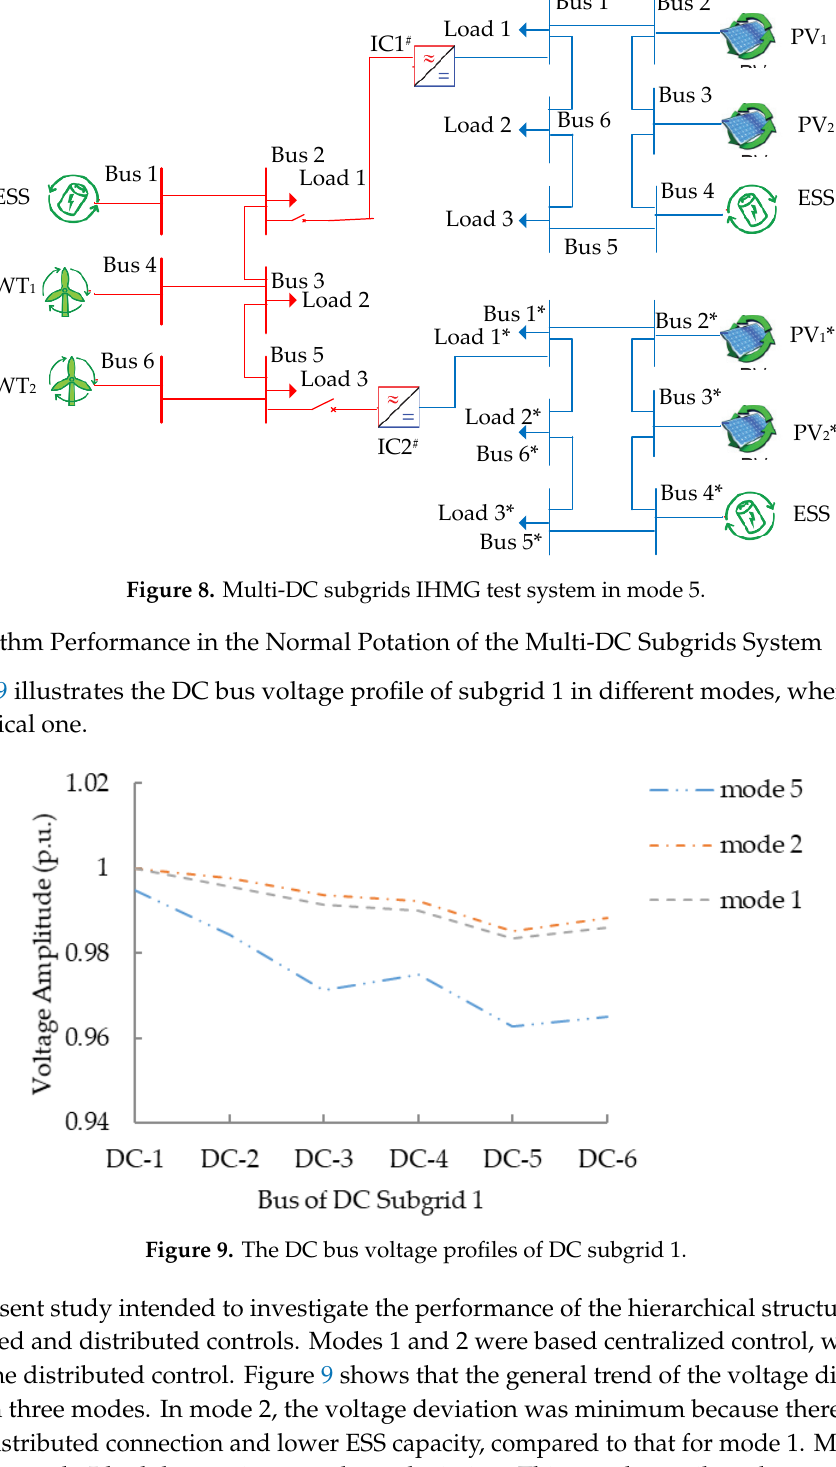
Figure 7. Multi-DC subgrids IHMG test system in mode 2.